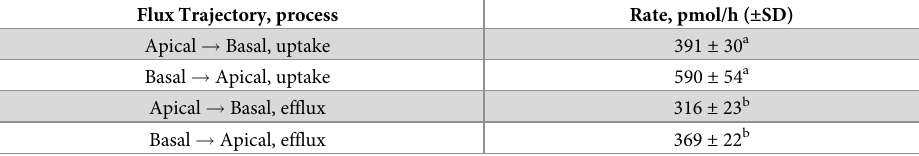
Table 1. Rates corresponding to fitted lines in Fig 4. Flux Trajectory, process Rate, pmol/h ( ± SD) Apical ! Basal, uptake 391 ± 30 a Basal ! Apical, uptake 590 ± 54 a Apical ! Basal, efflux 316 ± 23 b Basal ! Apical, efflux 369 ± 22 b a, b Significantly different at p < 0.0001. Values from fit of data in Fig 4 to standard exponential (Prism